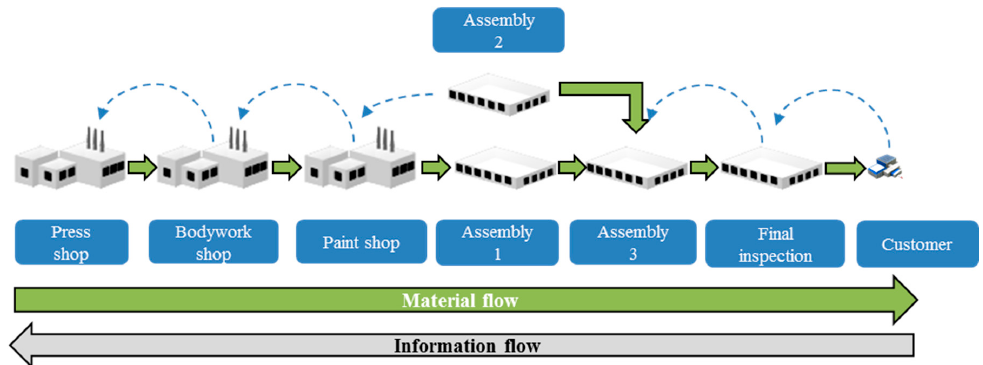
Figure 9. Simulation production flow (own elaboration).